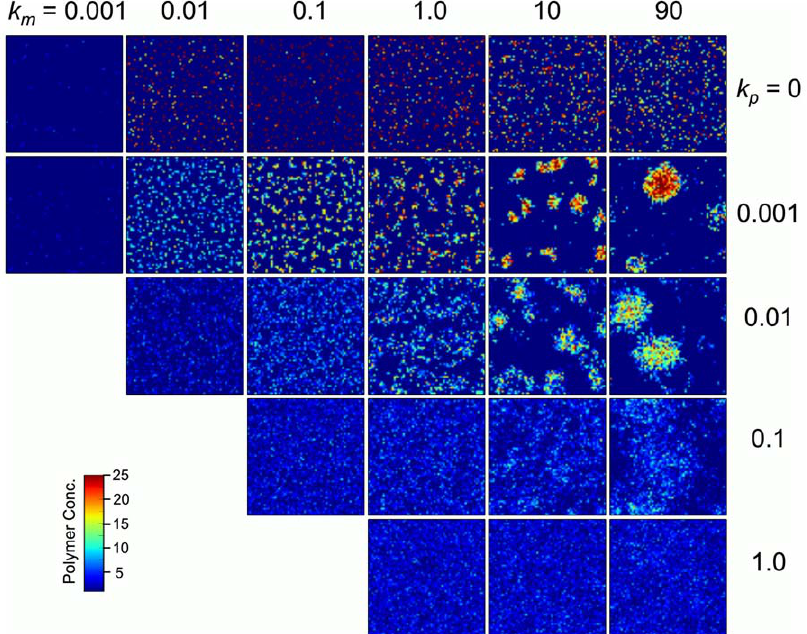
Figure 3. Spatial maps of polymer density. Each column of images corresponds to simulations run with a different value for monomer diffusivity k m (in sites/cycle), and each row has a different value for polymer diffusivity k p (in sites/cycle). All data shown are for kinetic rate constants k s ~ 10 { 7 , k r ~ 10 { 4 , and k h ~ 0 : 1 . All maps correspond to t ~ 3000 cycles. The color scale is in units of polymers/site. Simulations were only run for cases in which monomer diffusivity is greater than or equal to the polymer diffusivity.